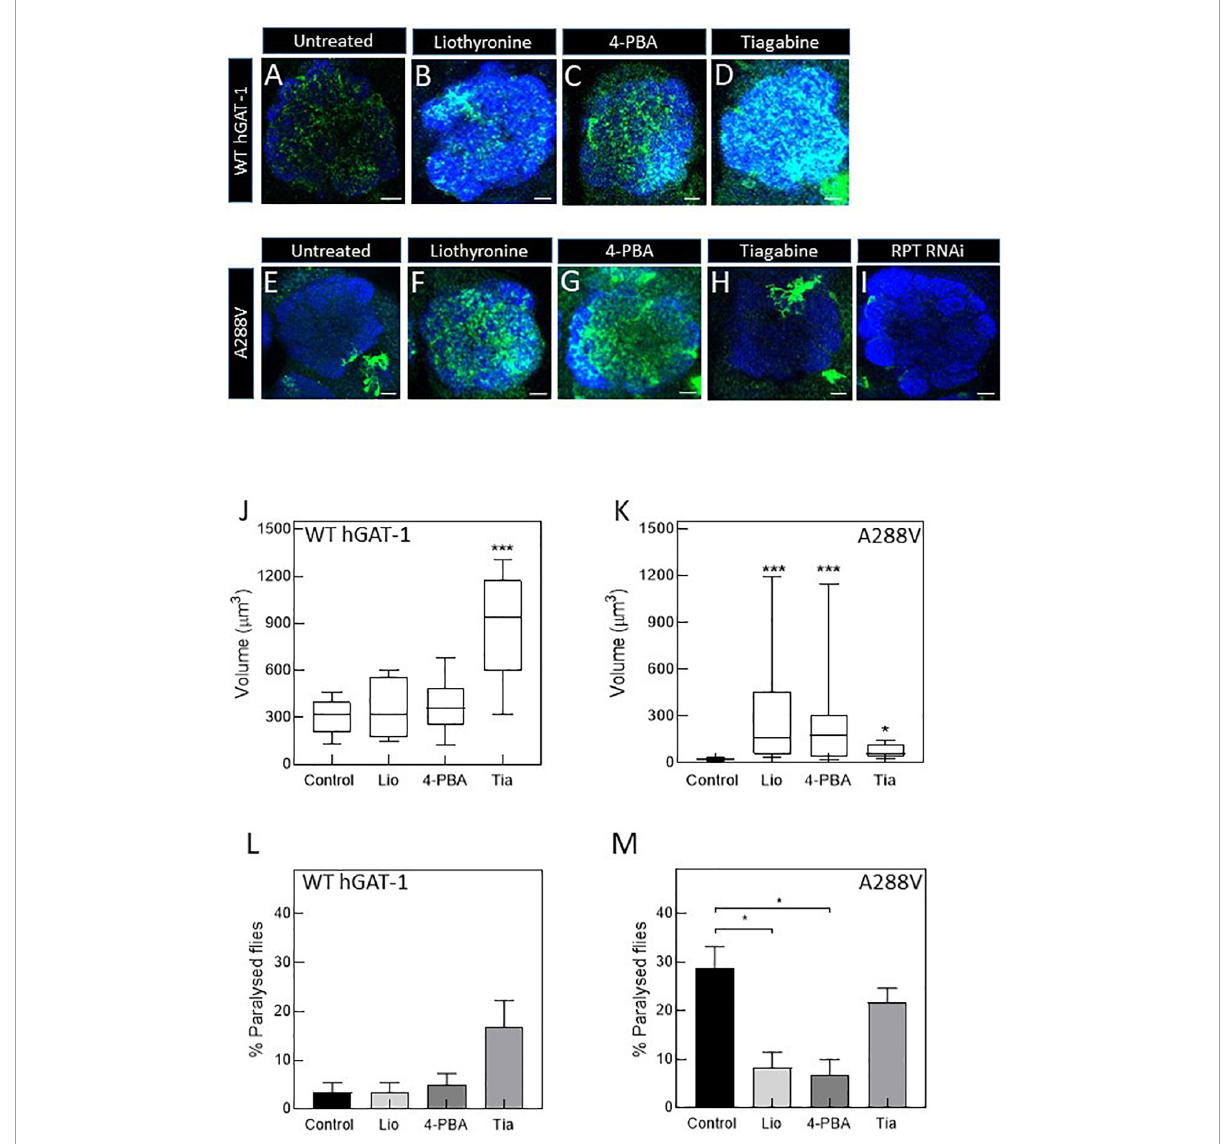
FIGURE6 Pharmacological treatment restores the expression and activity of the A288V mutant in fruit flies. Panel (A–D) show astrocytic expression of WT human GABA transporter 1 (hGAT-1) in the single section of the antennal lobe of untreated (A) , 100 µ M liothyronine (B) , 1 mM 4-phenylbutyrate (4-PBA) (C) , and 100 µ M tiagabine (D) treated flies (Genotype:; ALRM-GAL4; UAS-YFP-hGAT-1 WT; ). Panel (E–H) show astrocytic expression of hGAT-1 A288V in the single section of the antennal lobe of untreated (E) , 100 µ M liothyronine (F) , 1 mM 4-PBA (G) , and 100 µ M tiagabine (H) treated flies (Genotype:; ALRM-GAL4; UAS-YFP-hGAT-1 WT; ). (I) Proteasomal degradation was studied using RPT1-RNAi (genotype; ALRM-GAL4/ + ; UAS-YFP-hGAT1-A288V, UAS-RPT1; ). (J,K) , Expression of the WT hGAT-1 and A288V in the antennal lobe of untreated and treated flies, respectively. The expression of the transporter was quantified using Imaris 9.3 in 10 adult brains of each condition. The statistical comparison was done by analysis of variance followed by Dunn’s post-hoc test ( n :10, * p < 0.05, *** p < 0.001). WT hGAT-1 and A288 flies received the food supplemented with drug for 48 h and were either dissected and imaged or were used to study seizure susceptibility [ (L,M) , respectively]. Means ± S.E.M. are indicated from at least six independent experiments performed with 10 flies per condition. The statistical comparison was done by analysis of variance followed by Dunn’s post-hoc test (* p < 0.05, significantly different from control). Scale bar = 10 µ m. Each image is representative of at least 10 additional images per condition. Brain neuropiles are labeled in blue by